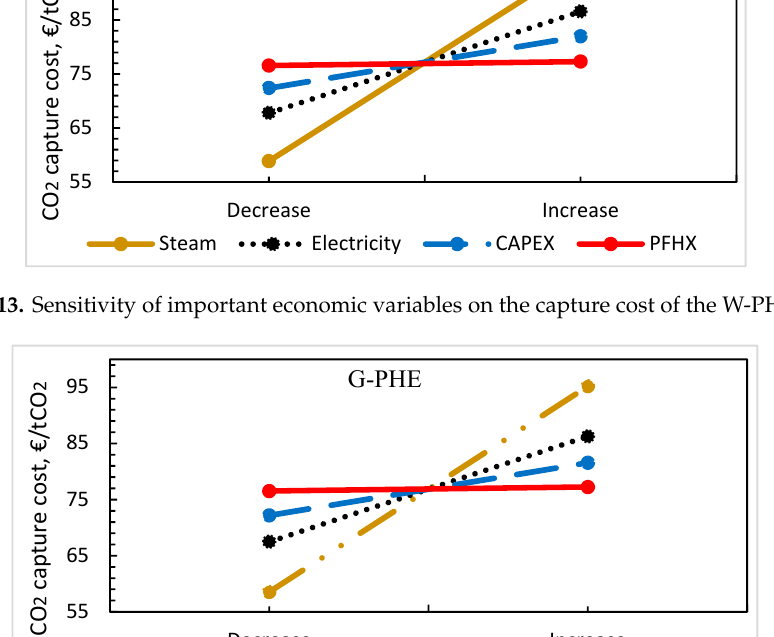
Figure 14. Sensitivity of important economic variables on the capture cost of the G-PHE case.